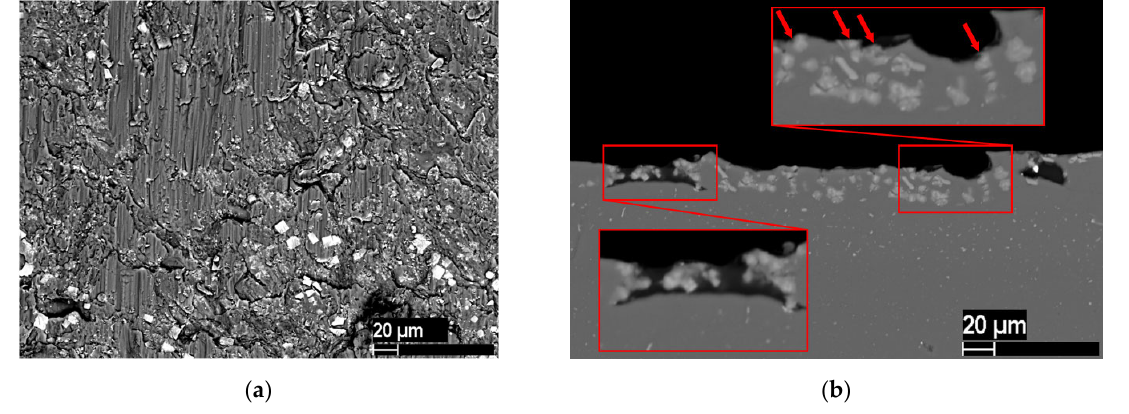
Figure 17. SEM images of the AA 6082/AA 6082 joint brazed according to the 540 °C/30 min mode. Different fracture views at 1000× magnification: ( a ) surface fractogram with z ‐ contrast; ( b ) cross ‐ section.